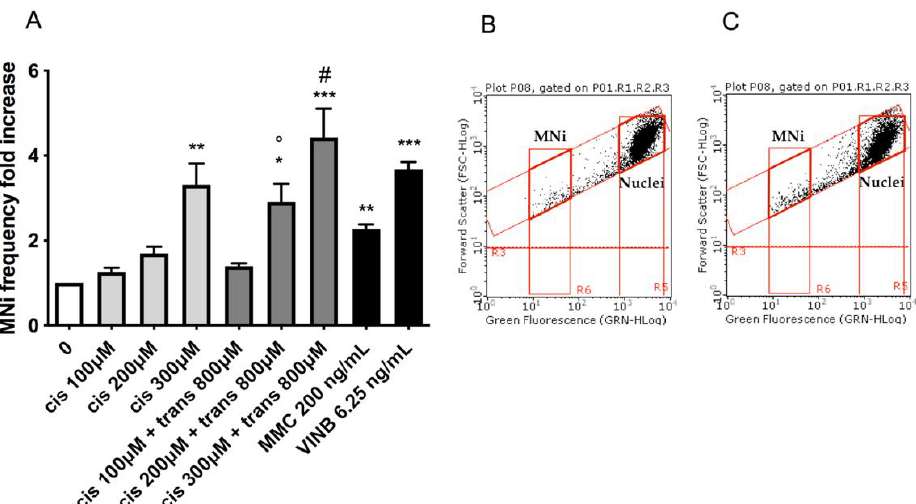
Figure 6. MNi fold increase in TK6 cells after 26 h treatment with ( ± )cis-4,4 (cid:48) -DMAR, ( ± )trans- 4,4 (cid:48) -DMAR, their associations or positive controls (MMC, VINB) at the indicated concentrations compared to the concurrent negative control [0 µ M] ( A ). Each bar represents the mean ± SEM of three independent experiments. Data were analysed using one-way repeated measures ANOVA followed by Dunnet as post-test. * p < 0.05 vs. [0 µ M]; ** p < 0.01 vs. [0 µ M]; *** p < 0.001 vs. [0 µ M]. ◦ p < 0.05 vs. [cis 200 µ M]. # p < 0.05 vs. [cis 300 µ M]. Dot plots obtained by FCM in cis 200 µ M ( B ) and cis 200 µ M + trans 800 µ M ( C ). “MNi” and “Nuclei” indicate the regions of the dot plot where MNi and nuclei can be